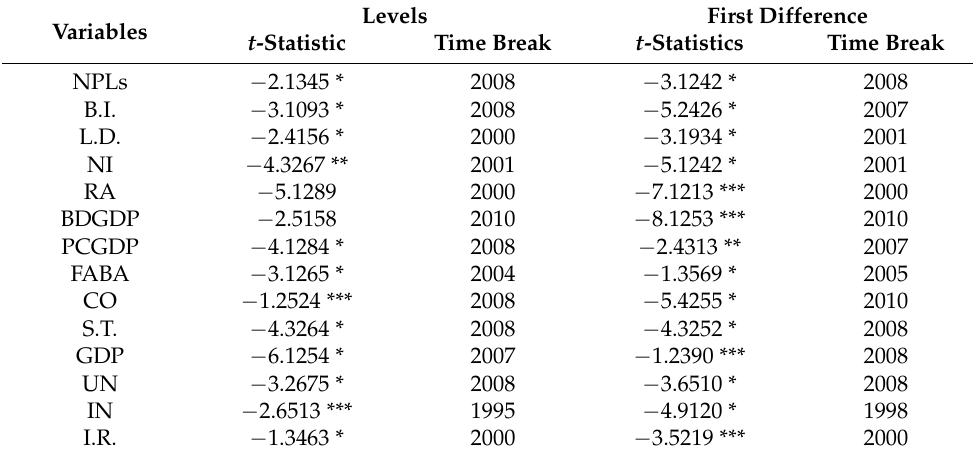
Table 4. Zivot and Andrews